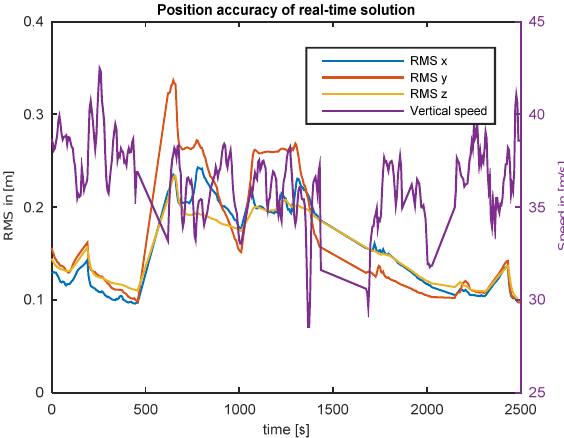
Figure 6: RMS of the sensor position in the real-time solution (left axis) and vertical speed of the helicopter (right axis)